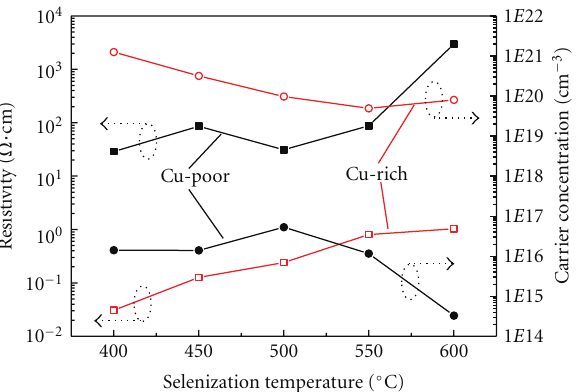
Figure 5: Resistivity (squares) and carrier concentration (circles) of CIGS films as a function of selenization temperature. Full and open symbols correspond to CIGS films selenized from Cu-poor precursor films and Cu-rich precursor films,